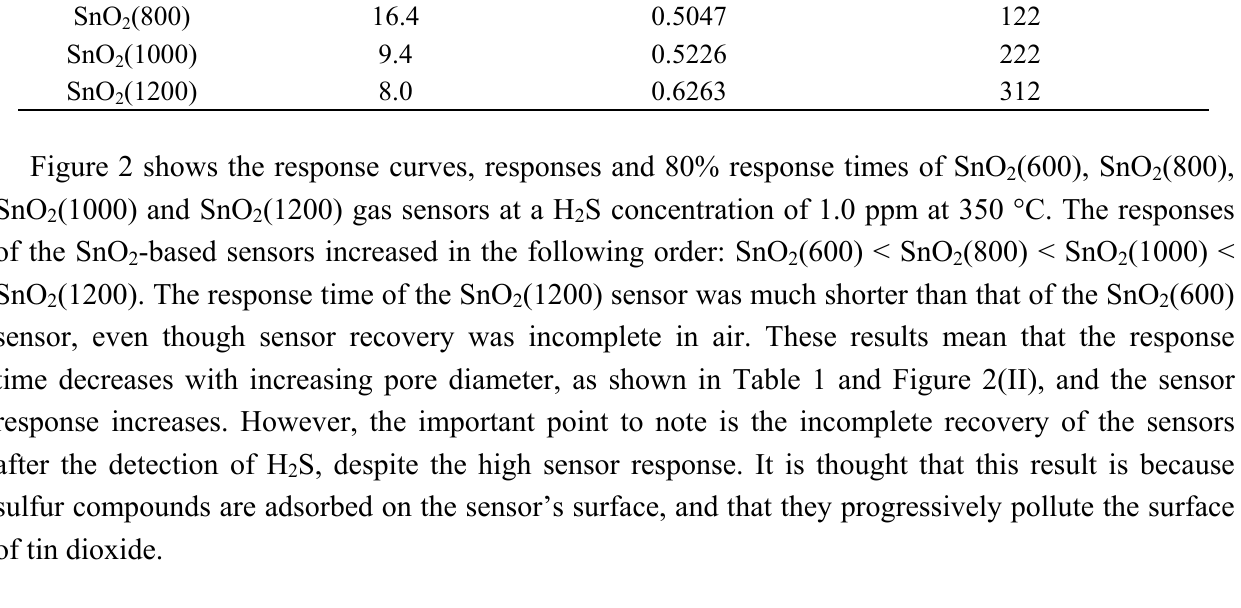
-based 2 (1200) at 2